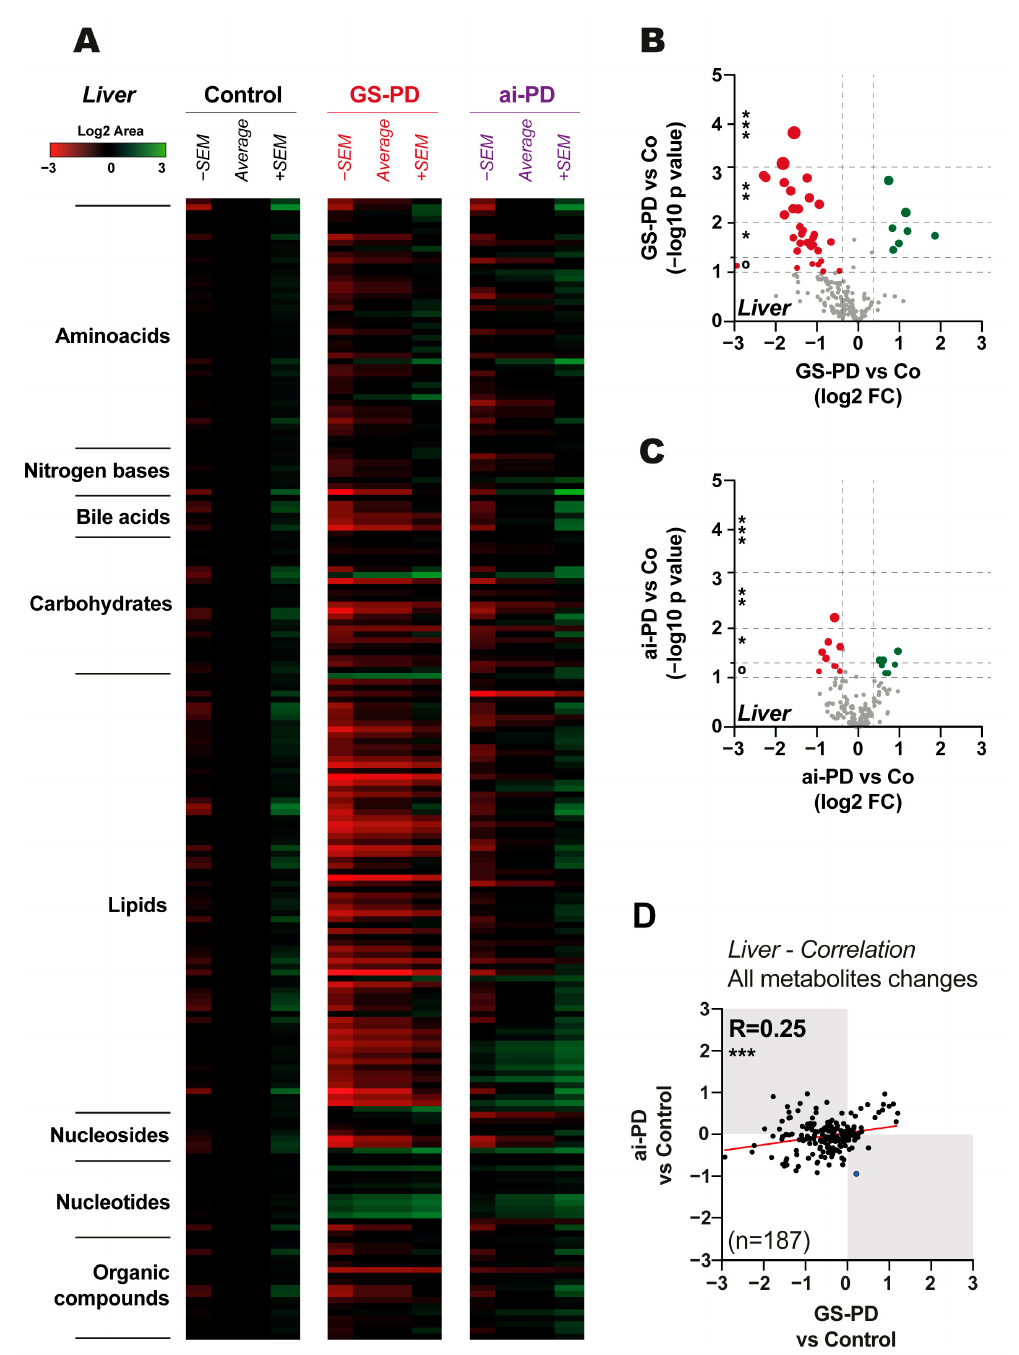
Figure 2. Results of metabolic changes observed in hepatic tissues for the control (Co) and parkin- sonian genetic (GS-PD) or due to acute intoxication (ai-PD) groups ( n = 4–5). ( A ) Heatmap with the average of the log2 area (± standard error of the mean (SEM)) showed by metabolite groups (amino acids, nitrogenous bases, carbohydrates, lipids, nucleosides, nucleotides and organic compounds). ( B , C ) Volcano plot graphs are shown. The log2 FC indicates the changes observed on GS-PD model ( B ) or ai-PD model ( C ) in comparison to control mice for each metabolite (represented by each dot). The − log10 p value represents non-significant (grey color) or significant (red represents signifi- cantly down-regulated metabolites, whereas green represents significantly up-regulated metabolites. ( D ) Correlation analysis between changes observed in striatal neurons of GS-PD or ai-PD compared to controls. Statistical analysis was performed by obtaining p value ( ◦ ( p < 0.1), * ( p < 0.05), ** ( p < 0.01), *** p < 0.001), and Pearson’s correlation coefficients (R) between the observed